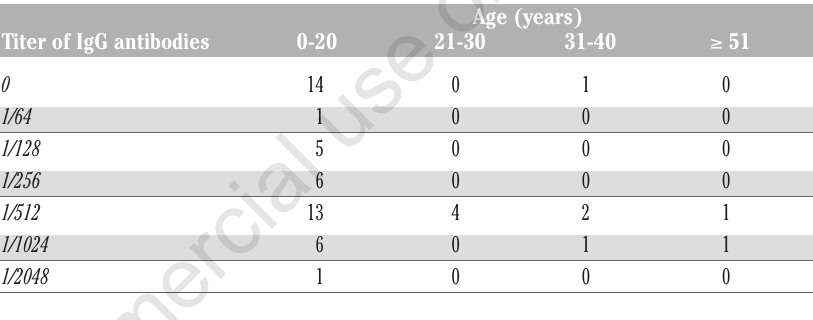
Table 1. Distribution of IgG titers in each age group.